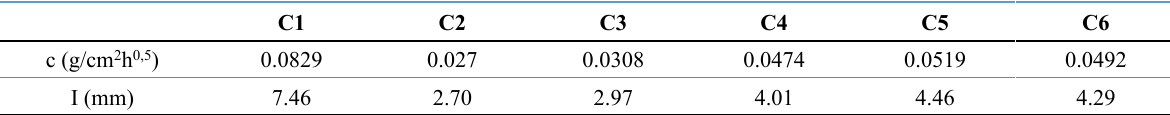
Figure 5. Capillary water absorption versus square root of time. Table 8. Capillary absorption coefficient and maximum water penetration height.